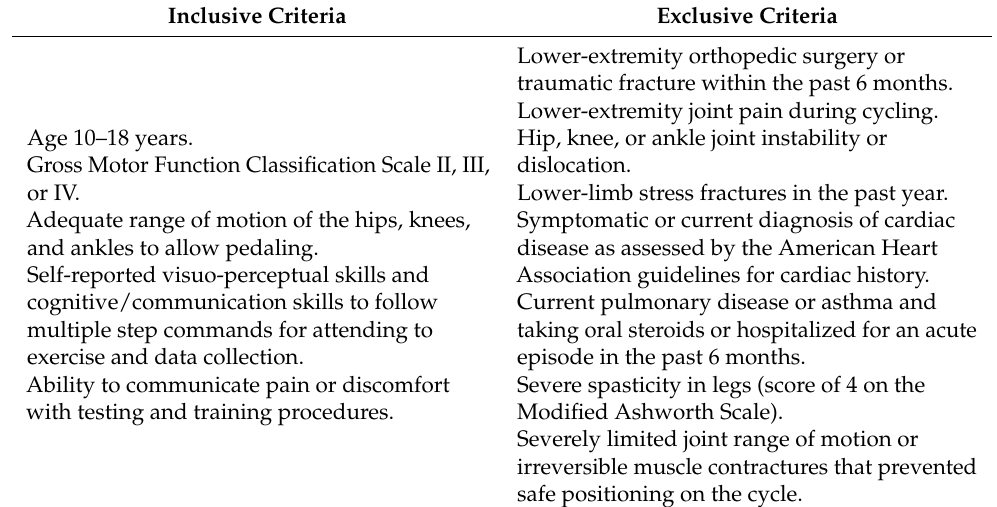
Table 1. Inclusion and exclusion